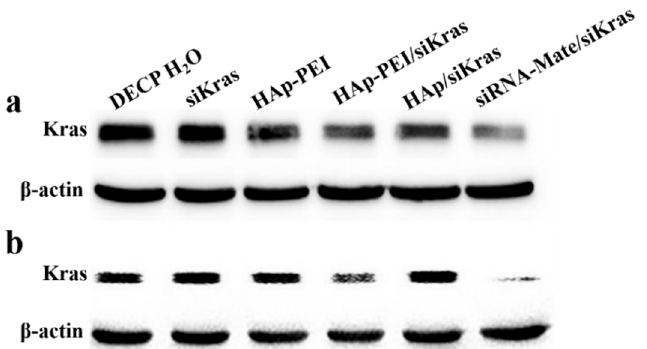
Figure 8. Expression of Kras protein in ( a ) PANC-1 and ( b ) CFPAC-1 cells after siKras transfection for 48 h by HAp-PEI, Hap, and siRNA-Mate. DECP H 2 O, siKras and HAp-PEI treatment were used as control.